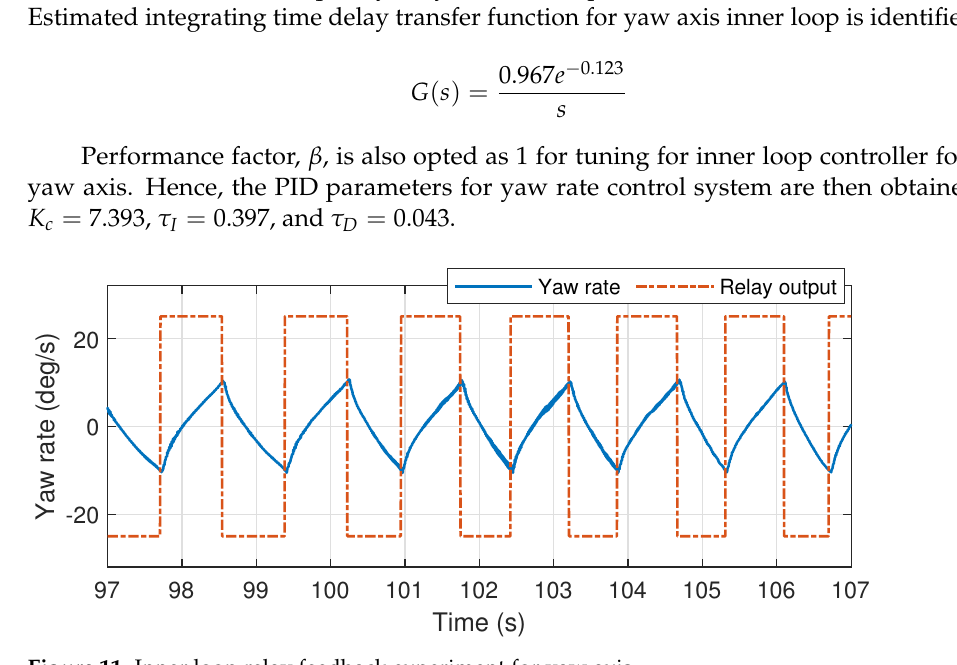
τ I = 2.134, and τ D = 0.107 for the roll axis. In a similar manner, the PID parameters for the pitch axis are determined as K p = 1.501, τ I = 2.115, and τ D = 0.106. Subsequently, for the yaw axis, PID controller parameters for outer loop are tuned as K p = 1.644, τ I = 1.931, and τ D =